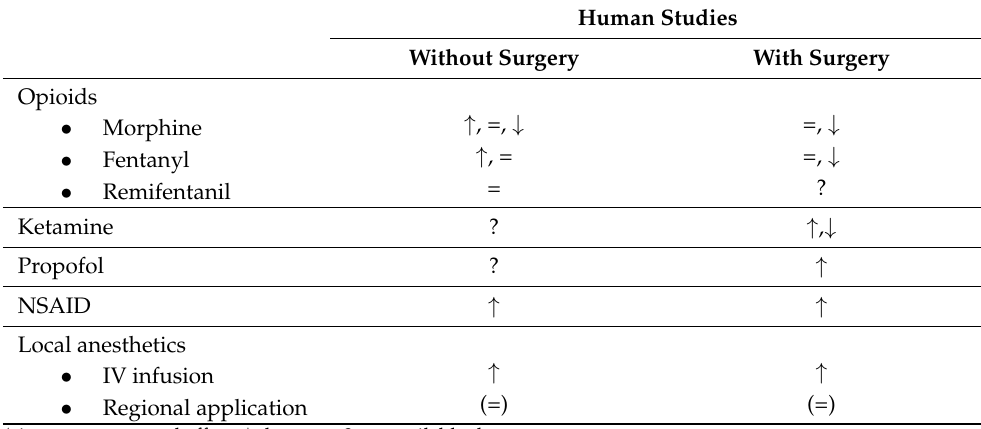
Table 1. Natural killer cell activity: Influence of commonly used drugs in anesthesia.